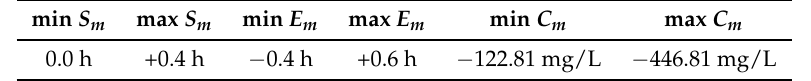
Table 5. Richmond network minimum and maximum errors ( S m , E m and C m ) for 30 runs.